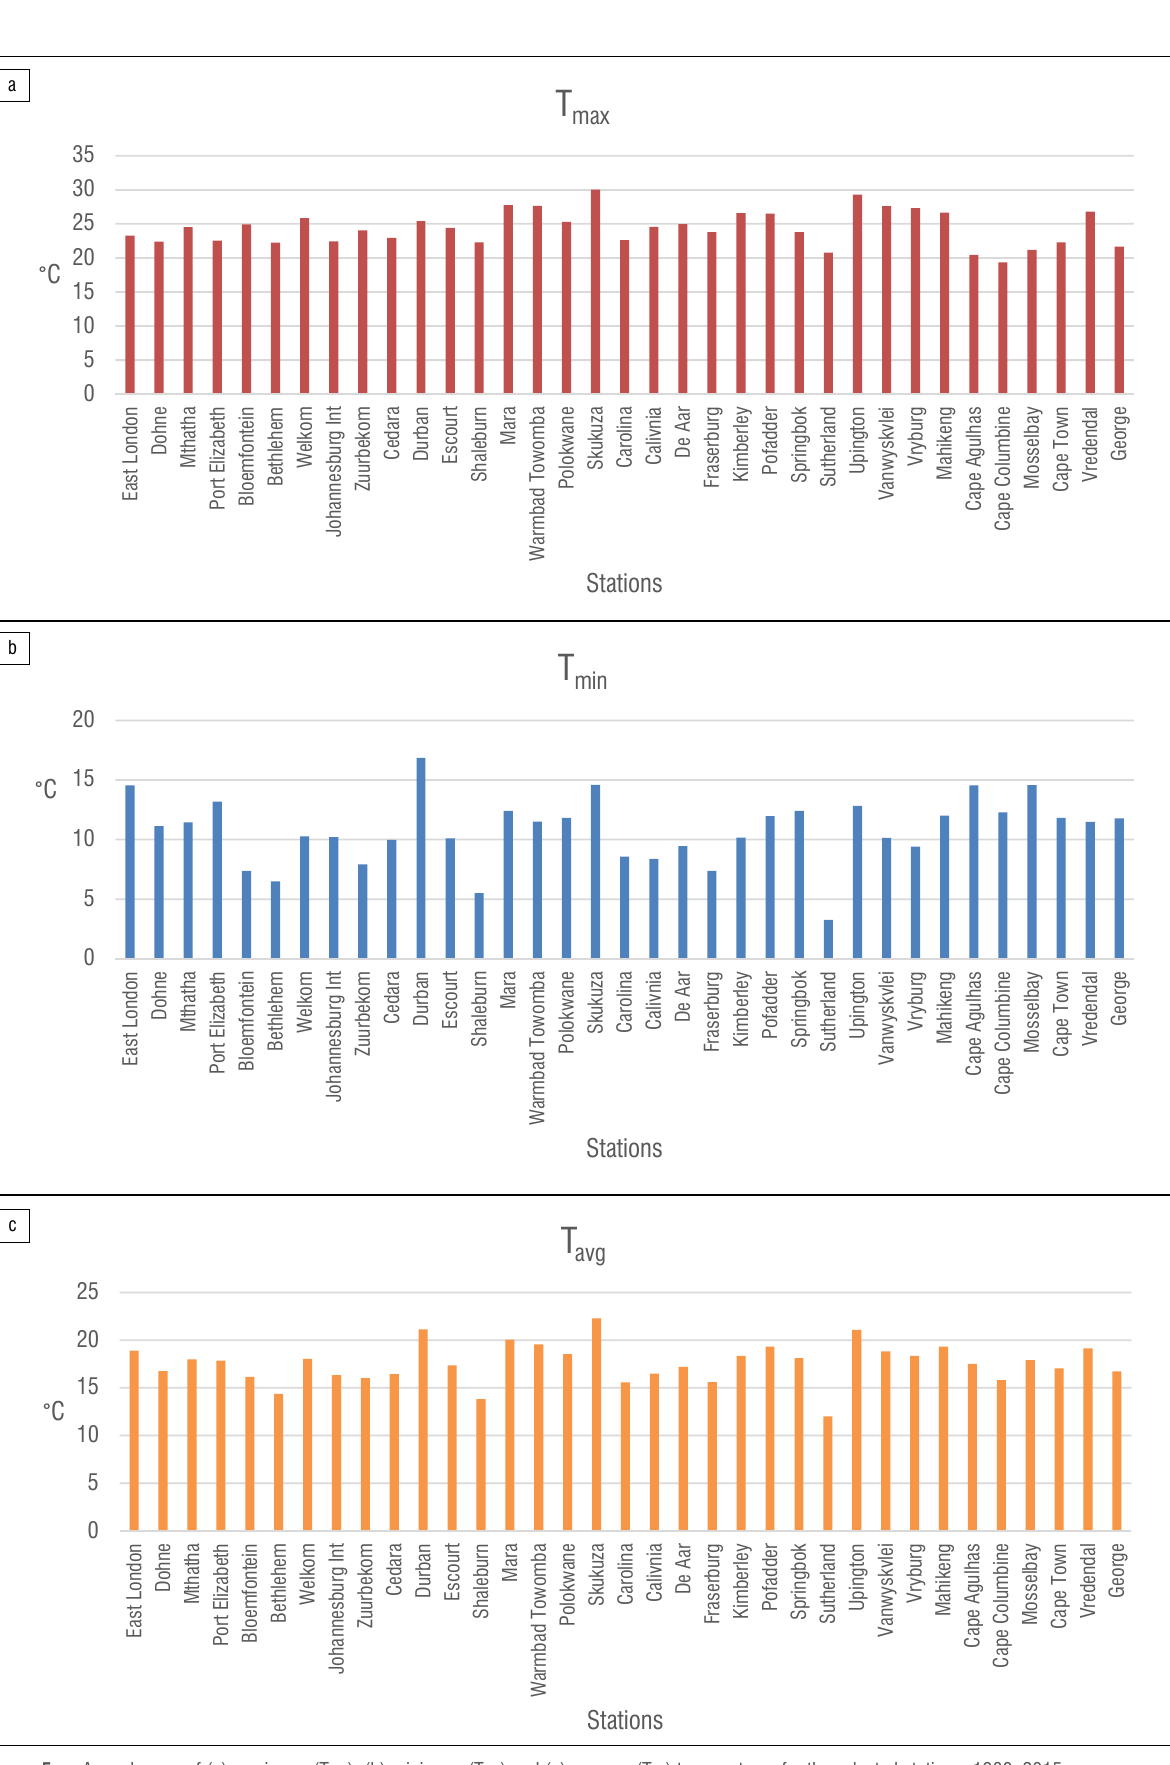
), (b) minimum (T ) and (c) average (T ) temperatures for the selected stations, max min avg